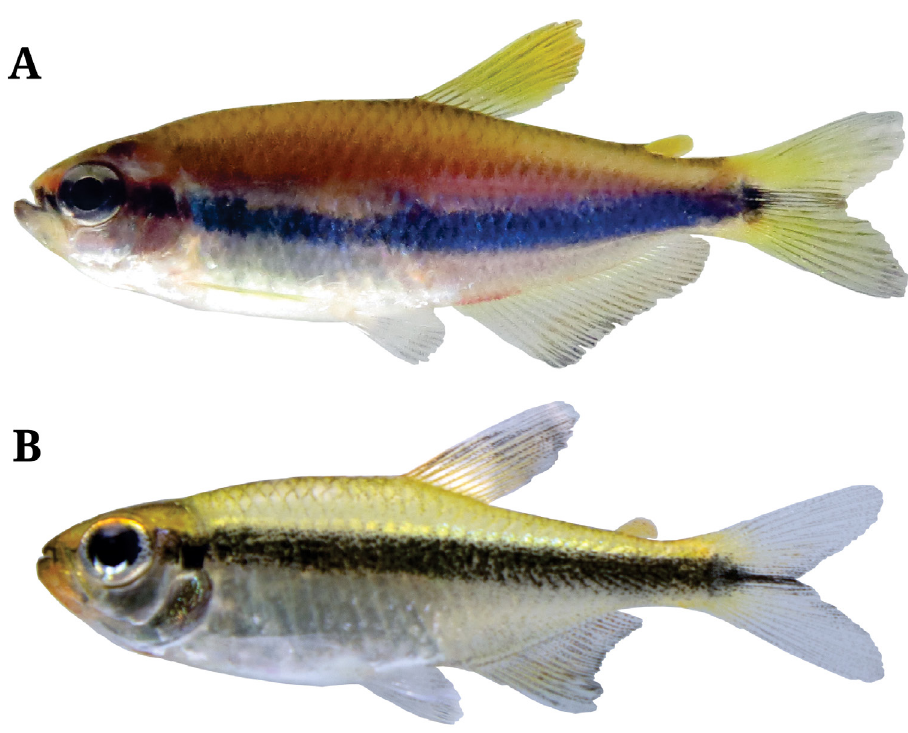
FIGURE 1 | Lateral view of A. Inpaichthys kerri , 34 mm SL; and B. Hyphessobrycon vilmae , 32 mm SL. Photos: A. R.